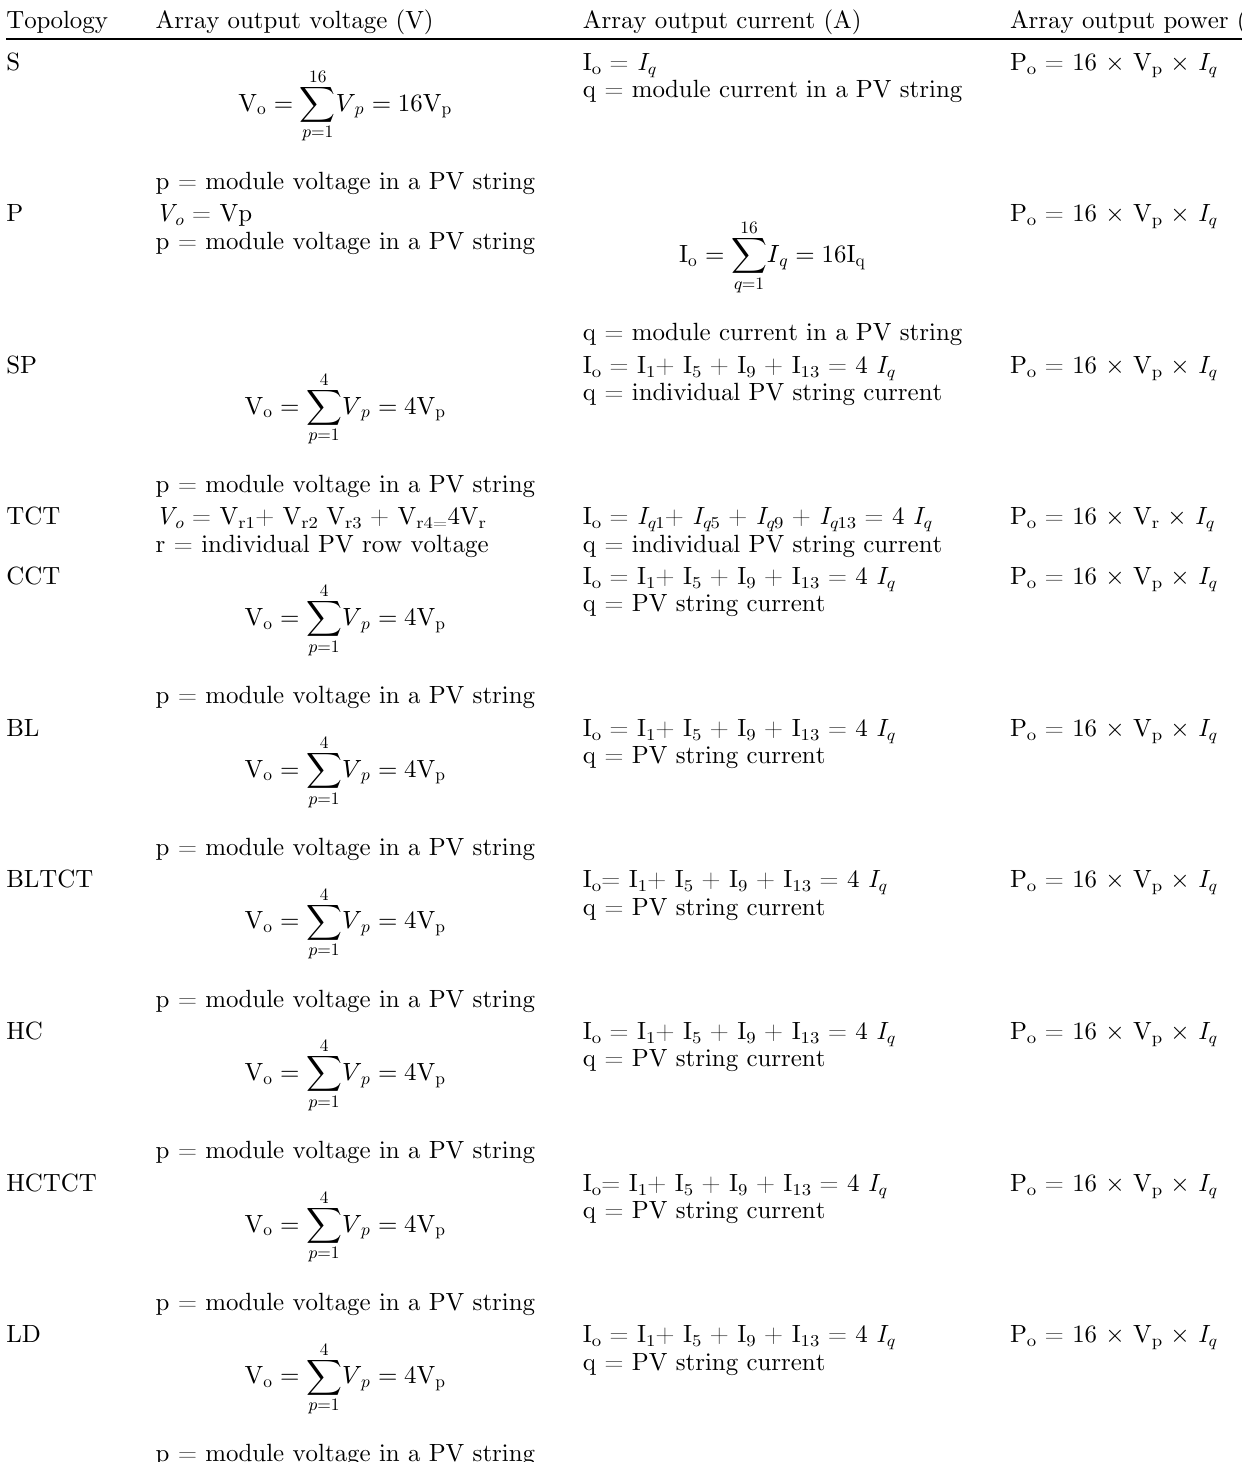
Table 4. Different array topologies output voltage, current and the respective power expressions.